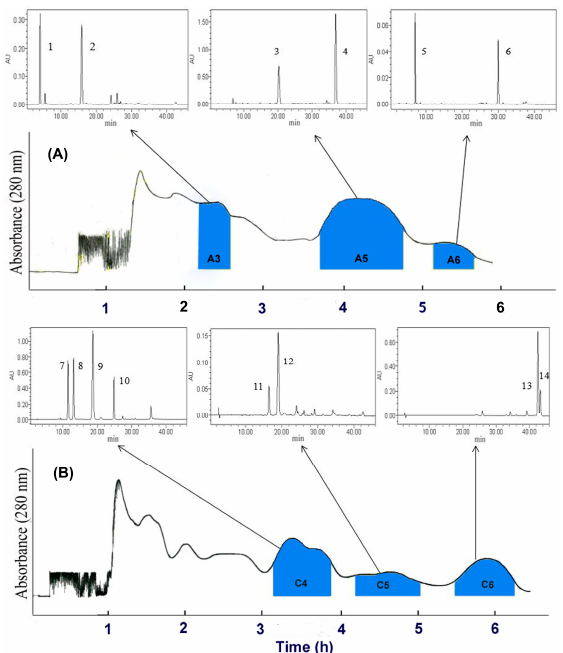
Figure 1. HSCCC-UV chromatograms of EtOAc extract and the upper pumped from column tail, and HPLC analysis corresponding to the HSCCC peak fractions. ( A ) Solvent systems of the first CCC run, petroleum ether-ethyl acetate-methanol-water (1:9:1:9, v / v / v / v ); ( B ) Solvent systems of the second CCC run, petroleum ether-ethyl acetate-methanol-water (1:2:1:2, v / v / v / v ); flow rate 2 mL/min; detection at 280 nm. A3, A5, A6, C4, C5 and C6 represent the combined major fractions. Molecules 2018 , 23 , 72